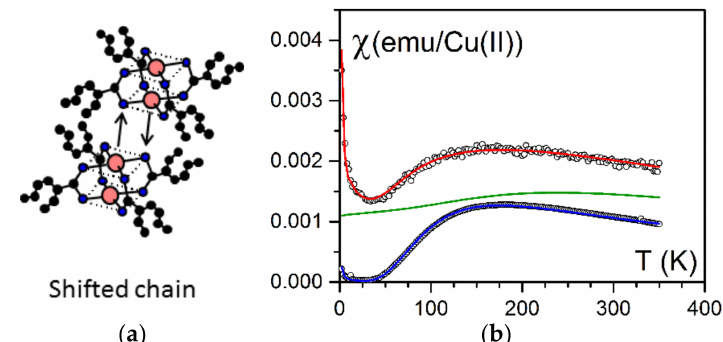
Figure 5. ( a ) How bicopper molecules piled up in the bulk state (shifted chains) [12]. ( b ) Magnetic susceptibility as a function of temperature. Blue = bulk state fitted with a Bleaney-Bowers law; red = encapsulated state fitted by relation (1) (see text) [14,22], green = theoretical variation for a spin chain [20].